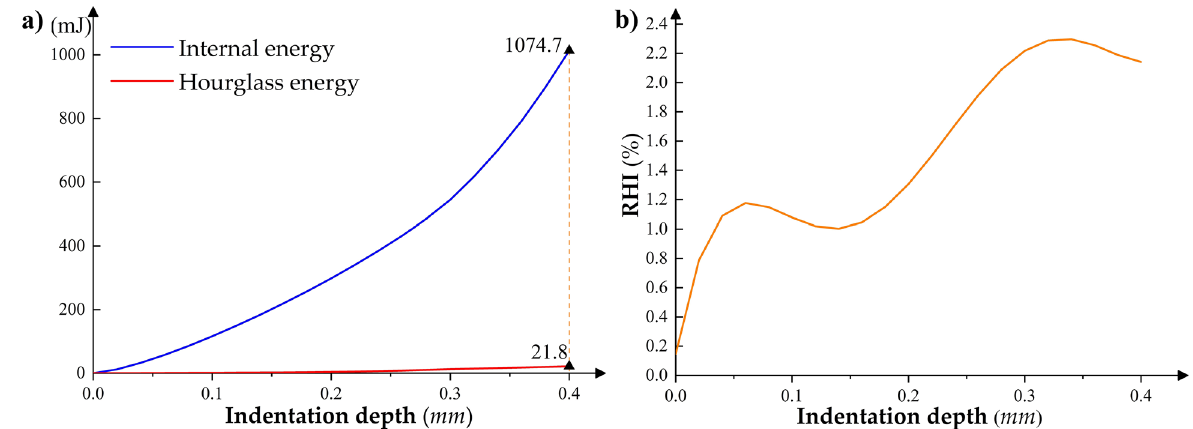
Figure 10. Variation of system energy with indentation depth during crimping simulation. ( a ) Internal energy and hourglass energy; ( b ) The “RHI” value as a function of indentation depth.